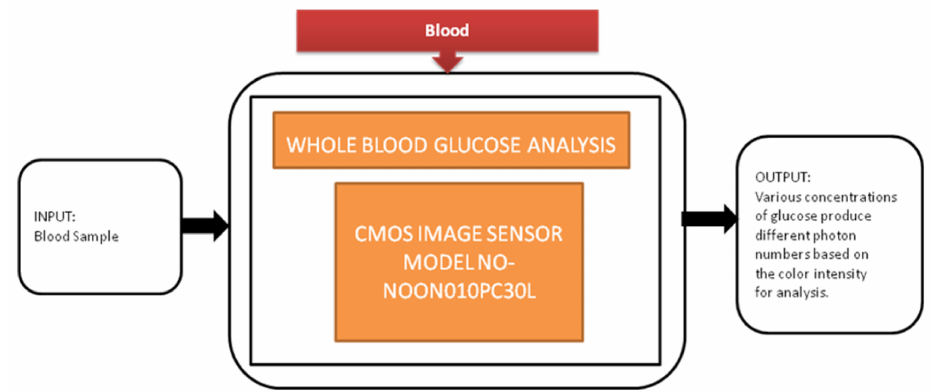
Figure 11. Whole glucose blood